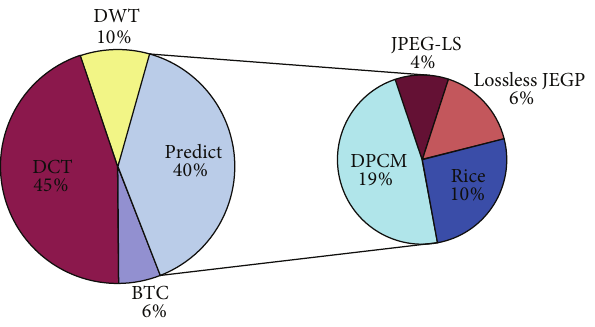
Figure 1: The statistics result of on-board image compression.